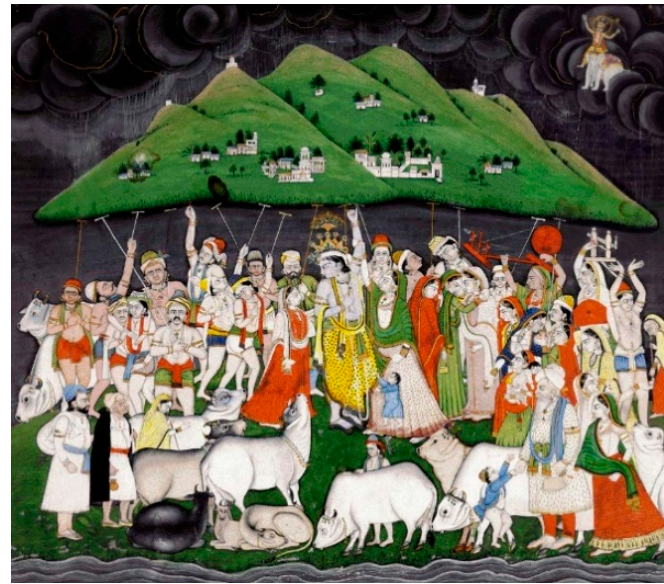
Figure 9. Krishna lifting Mount Govardhan 18 .